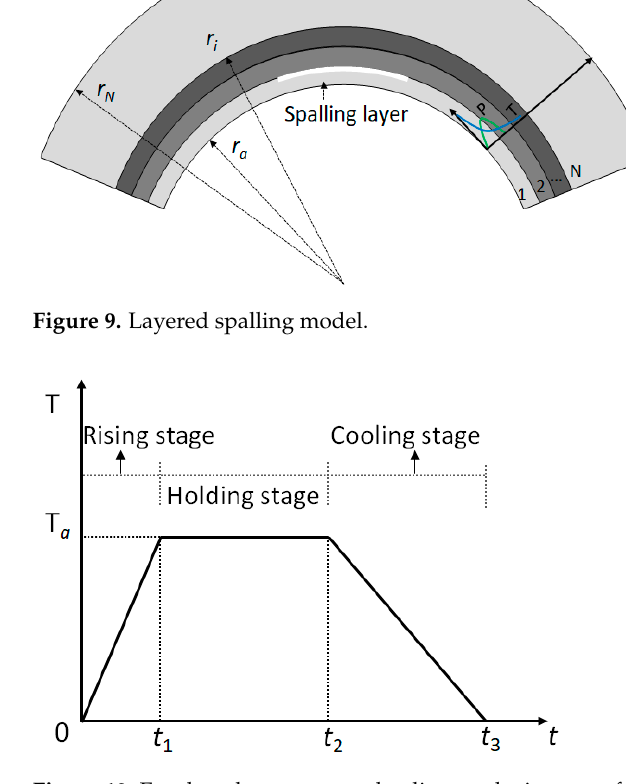
Figure 10. Employed temperature loading on the inner surface.